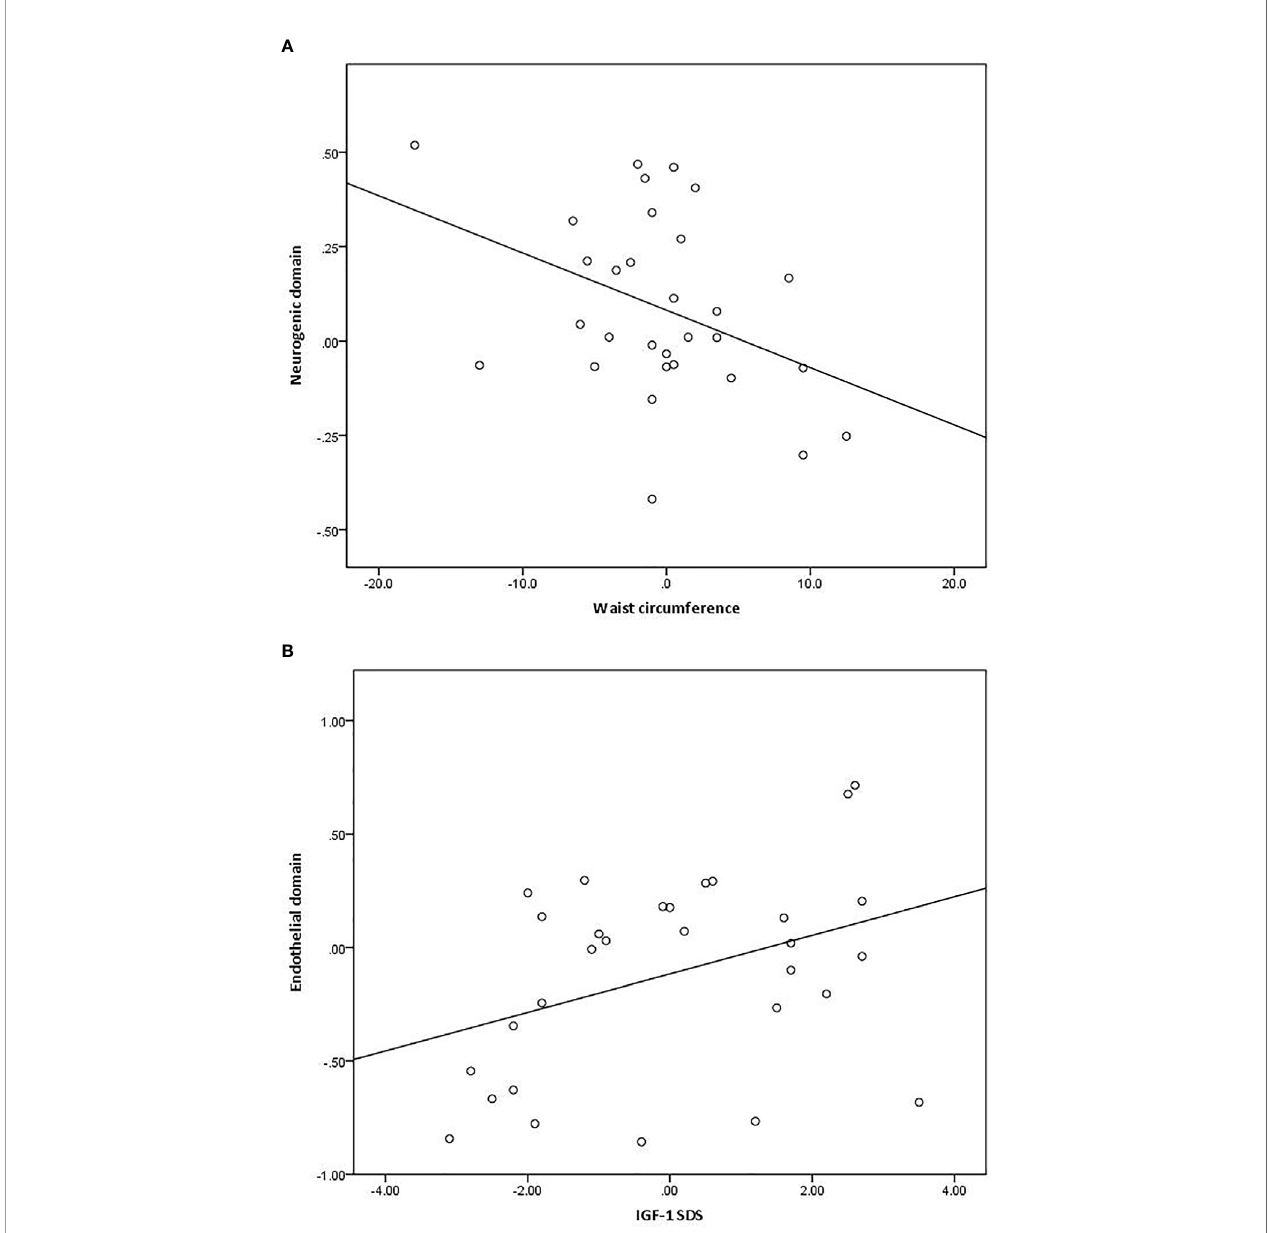
FIGURE 3 | Associations between change in the activity of the neurogenic vasomotion domain and waist circumference [ (A) ; r − 0.39, p<0.05] and the change in the activity endothelial vasomotion domain and IGF-1 standard deviation score (SDS) [ (B) ; r 0.38,